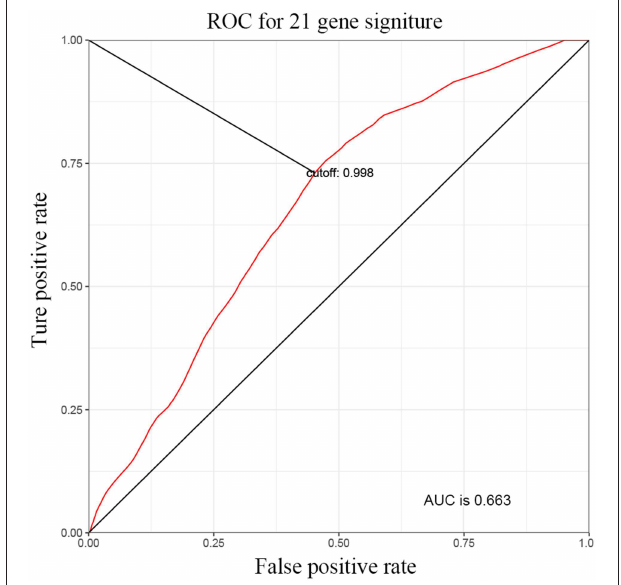
FIGURE 2 | Time-dependent ROC curve for the 21-miRNA signature. Intersection of black line with ROC curve corresponds to the risk score of 0.998 which was used as cut-off for the 21-miRNA to stratify patients into low or high-risk group.